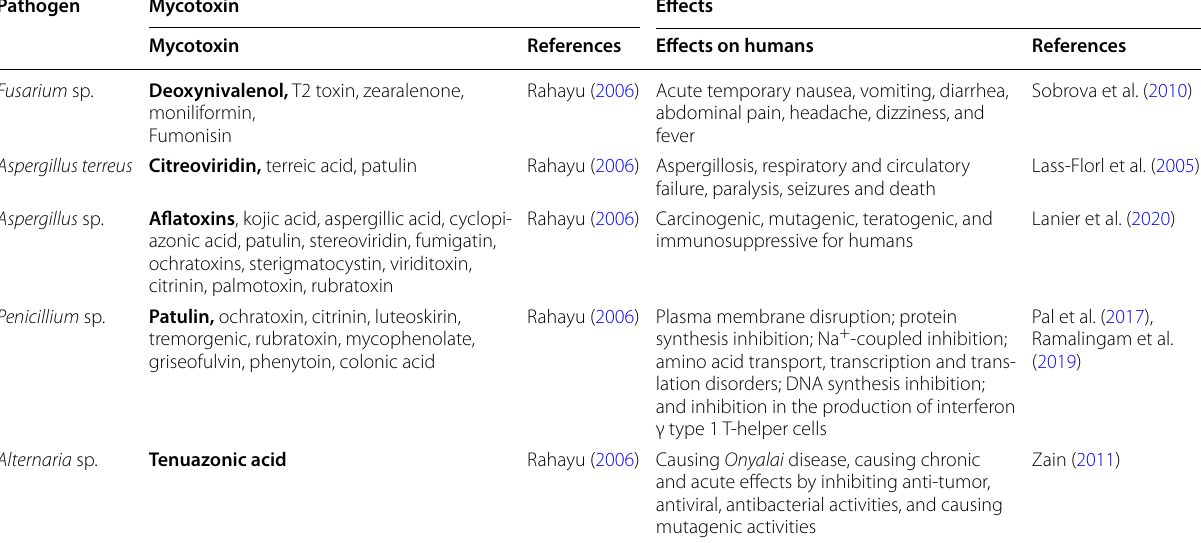
Table 2 Mycotoxins produced by fungi that cause postharvest diseases on citrus and subtropical fruits and their effects